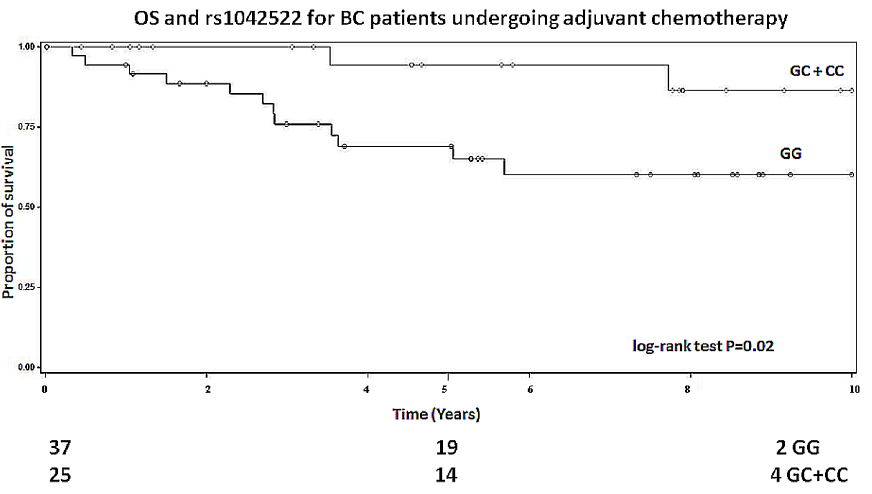
Fig 1. Kaplan-Meier overall survival curves for TP53 rs1042522 polymorphism in patients receiving only adjuvant chemotherapy (log-rank for recessive model P = 0.02). Numbers of patients at risk are indicated in the lower part of the